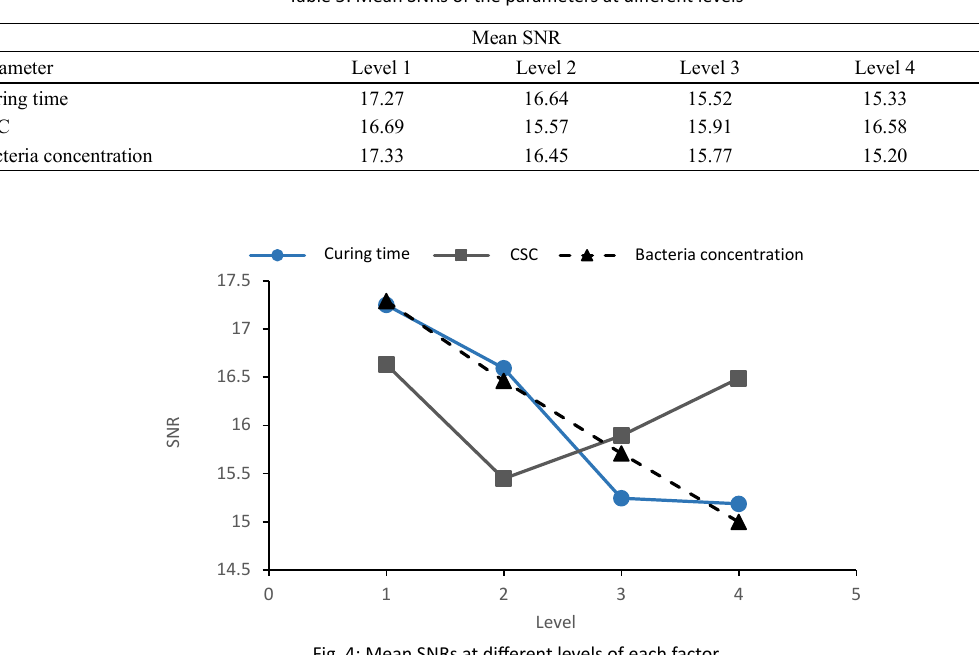
Table 5: Mean SNRs of the parameters at different levels